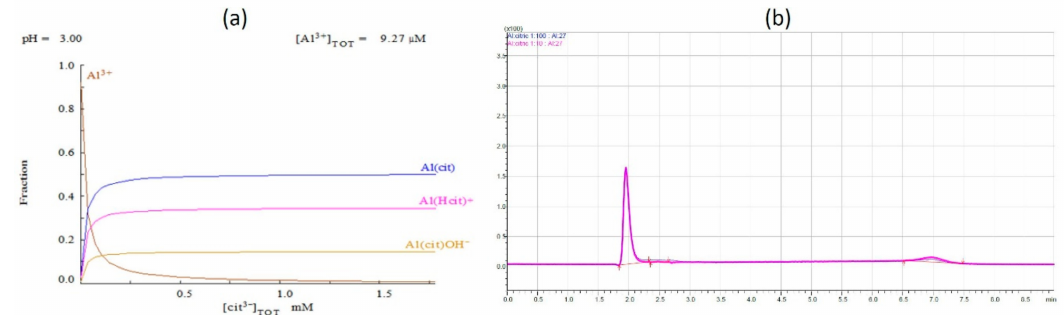
Figure 3. ( a ) Data from chemical modeling program for Al / citrate 1:1 and 1:100 molar ratio and ( b ) overlapped chromatograms for Al / citrate 1:10 and 1:100 molar ratio.